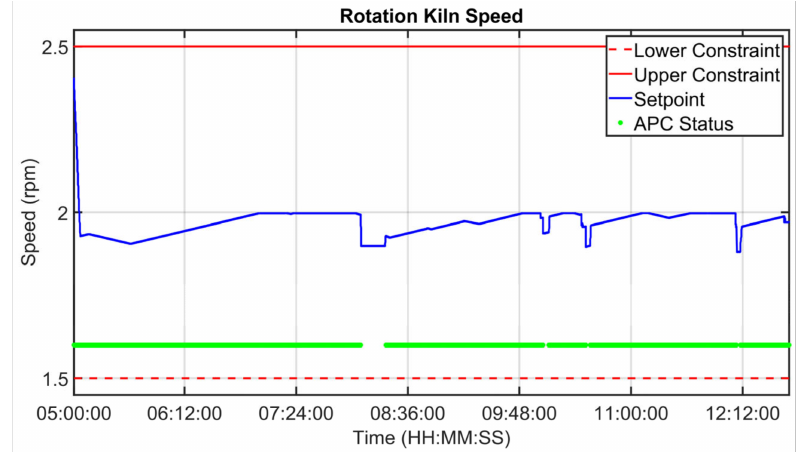
Figure 26. Rotary kiln APC system: field results (rotation kiln speed MV).